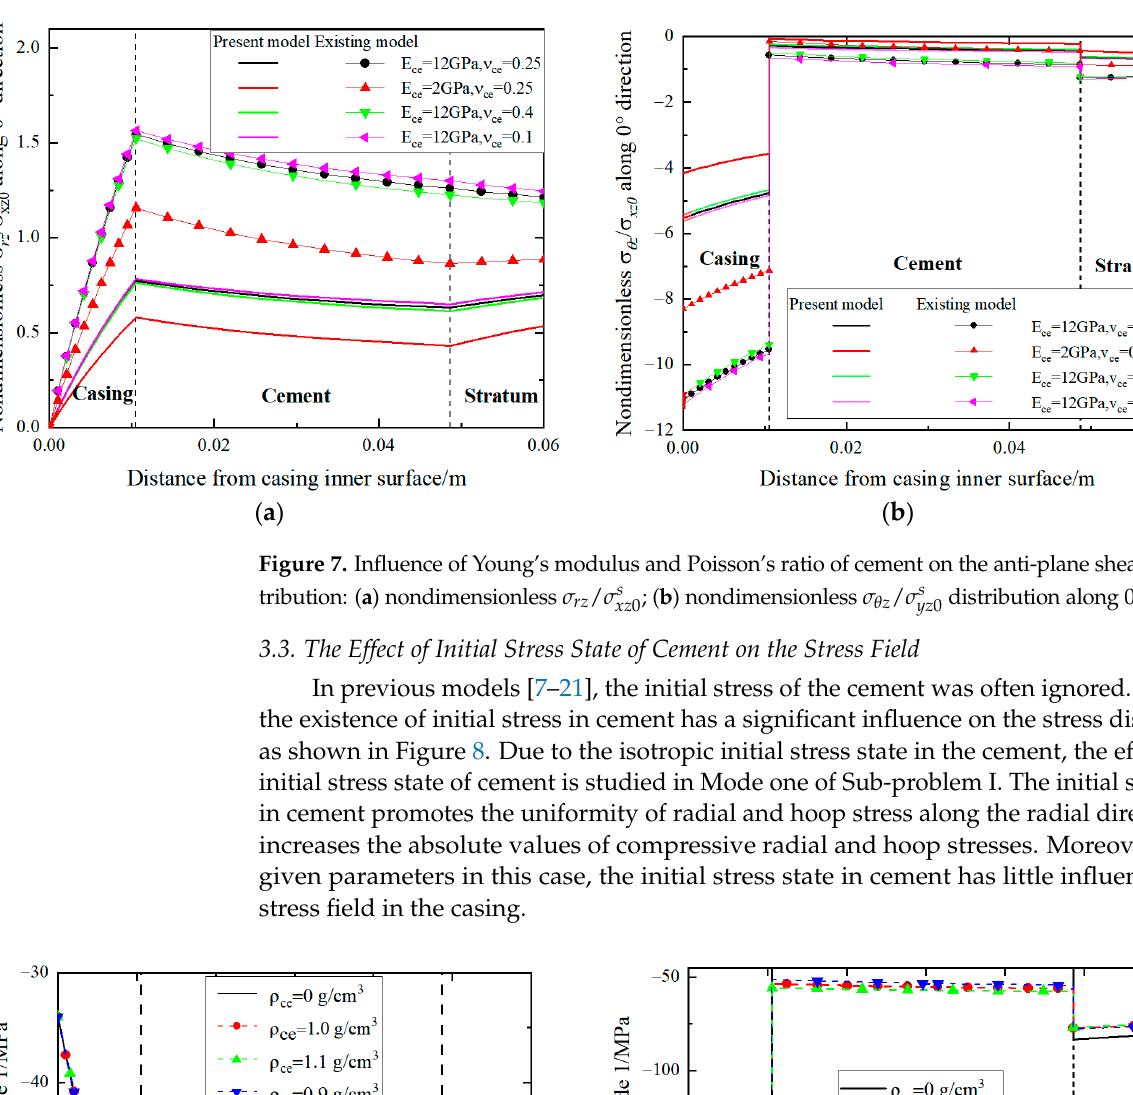
Figure 7. In fl uence of Young’s modulus and Poisson’s ratio of cement on the anti-plane shear stress distribution: ( a ) nondimensionless σ rz / σ s 0° direction.